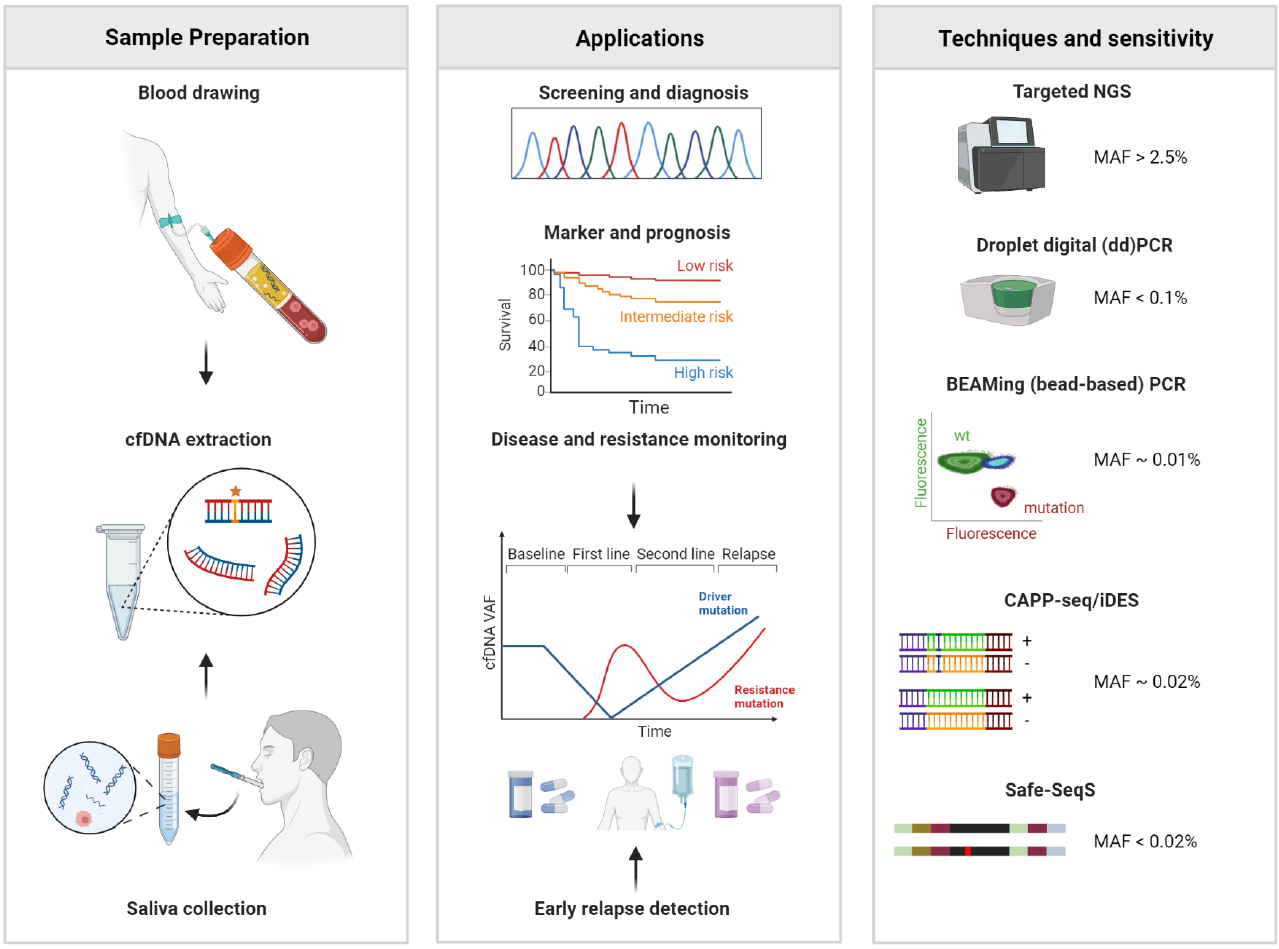
Figure 2. Liquid biopsy monitoring of cfDNA in HNSCC. In HNSCC, cfDNA is sampled from saliva or blood to diagnose, monitor and guide treatment decisions. Examples of technical approaches to quantify cfDNA in patient samples are indicated including thresholds of